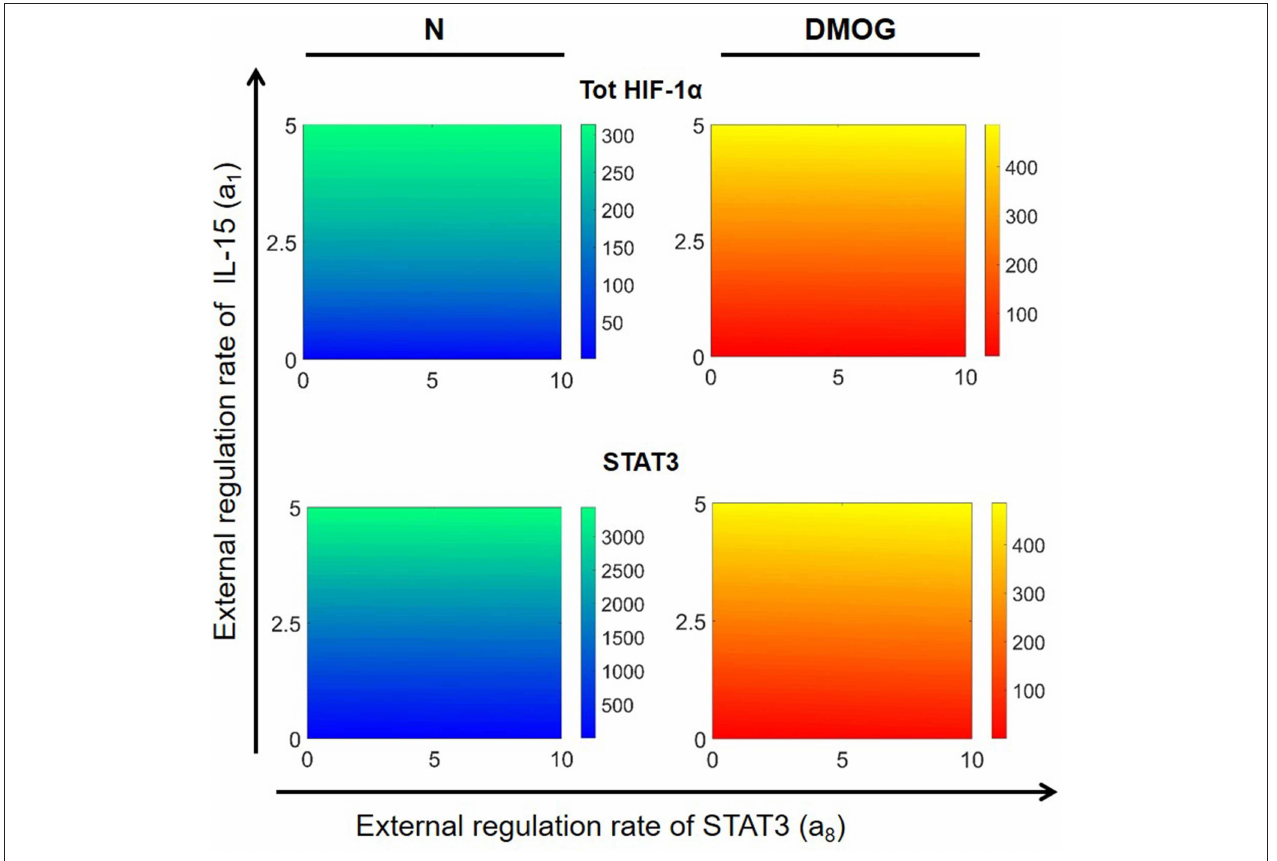
FIGURE 9 | Effects of external regulation of IL-15 ( a 1 ) and STAT3 ( a 8 ) in NK cells without DMOG (N, left) and DMOG treated cells (right). External regulation rates are varied in the intervals [0,5] nM h − 1 for IL-15 and [0,10] nM h − 1 for STAT3. Other parameters and initial values are fixed as in Tables 1 , 2 . Steady states (100 h) of the model solutions are computed for total HIF-1 α (first row) and STAT3 (second row).